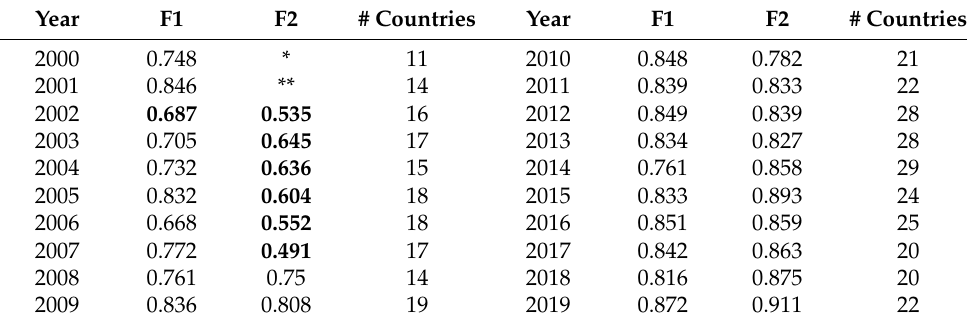
Table 5. Reliability statistics—Cronbach’s alpha, for two